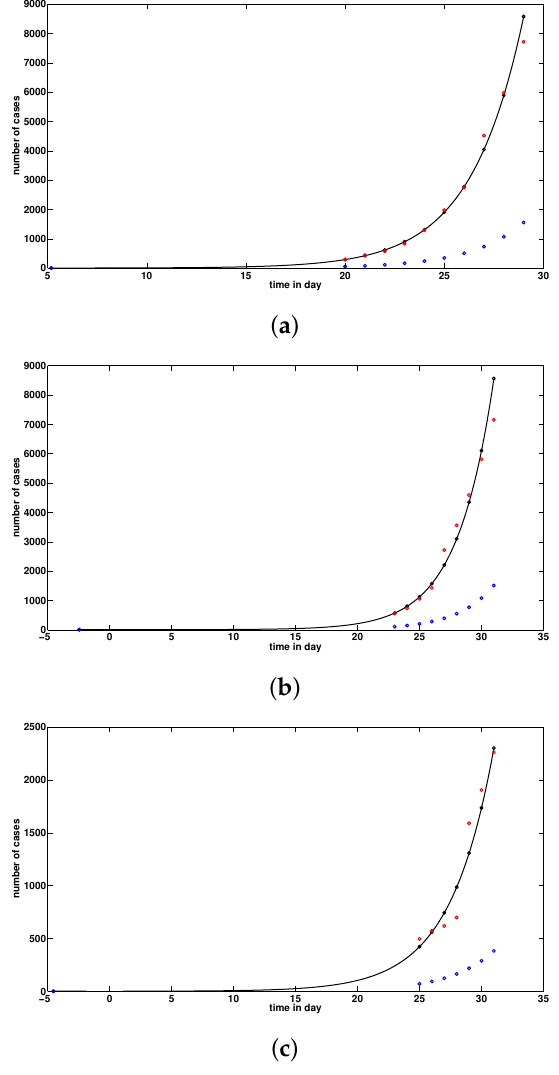
Figure 3. In these figures, we use f = 0.8, η = 1/7, ν = 1/7, and S 0 = 11.081 × 10 6 . The remaining parameters are derived by using (6)–(8). In ( a ), we plot the number of t → CR ( t ) (black solid line) and t → U ( t ) (blue dotted) and the data (red dotted) corresponding to the confirmed cumulated cases for mainland China in Table 2. We use χ 1 = 0.16, χ 2 = 0.38, χ 3 = 1.1, t 0 = 5.12 and S 0 = 11.081 × 10 6 which give τ = 4.44 × 10 − 08 , I 0 = 3.62, U 0 = 0.2 and R 0 = 4.13. In ( b ), we plot the number of t → CR ( t ) (black solid line) and t → U ( t ) (blue dotted) and the data (red dotted) corresponding to the confirmed cumulated case for Hubei province in Table 3. We use χ 1 = 0.23, χ 2 = 0.34, χ 3 = 0.1 and t 0 = − 2.45 and S 0 = 11.081 × 10 6 which give τ = 4.11 × 10 − 08 I 0 = 0.3, U 0 = 0.02 and R 0 = 3.82. In ( c ), we plot the number of t → CR ( t ) (black solid line) and t → U ( t ) (blue dotted) and the data (red dotted) corresponding to the confirmed cumulated cases for Wuhan in Table 4. We use χ 1 = 0.36, χ 2 = 0.28, χ 3 = 0.1, t 0 = − 4.52, and S 0 = 11.08 × 10 6 , which give τ = 3.6 × 10 − 08 , I 0 = 0.25, U 0 = 0.02, and R 0 =